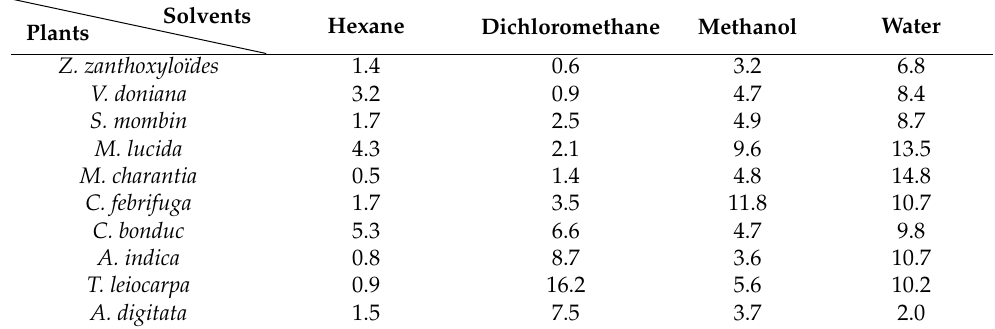
Table 3. Yield (% w / w ) of